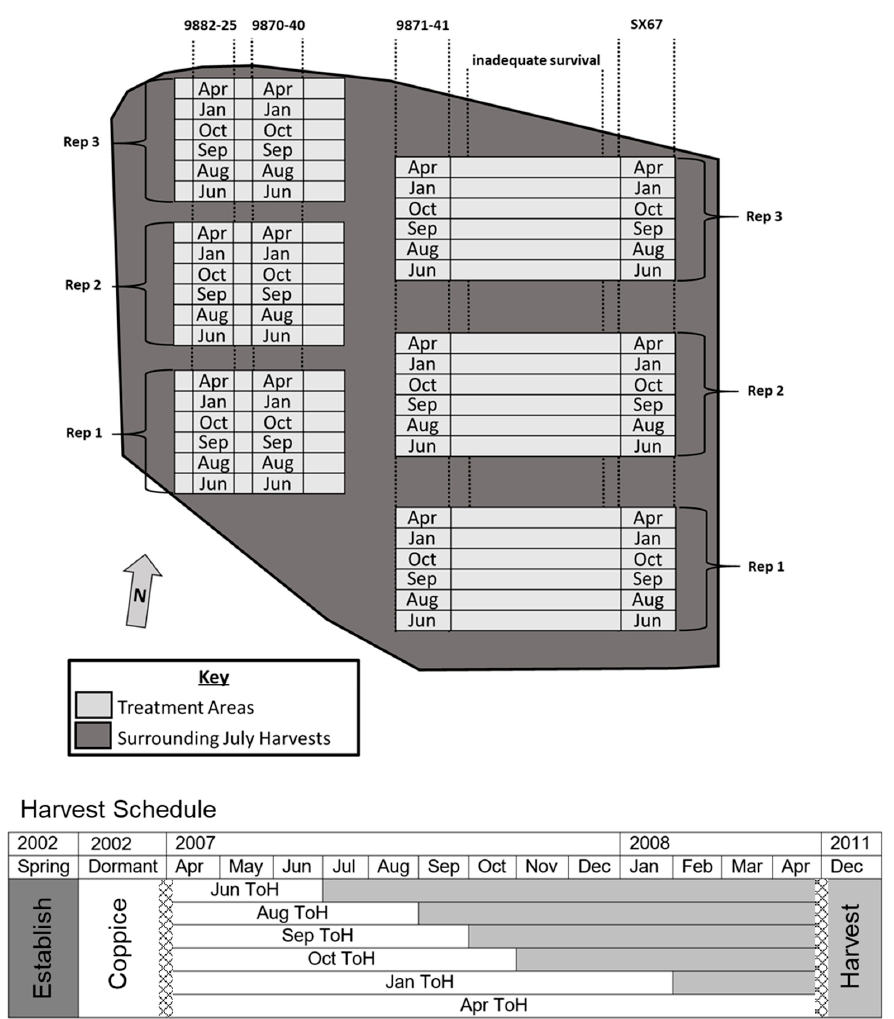
Figure 1. Schematic of the experiment with the four cultivars used in the study and layout of plots and replications. Dark grey area was harvested at the same time as the first harvest date (Jun). Grey areas indicate the time-of-harvest treatment (ToH) plots associated with the harvest dates, and areas that were treated but not included due to low survival. Table 2. Time of harvest, age of aboveground plant parts in months, growing degree days (GDD) for each harvest date, and stage of plant growth used to study the impacts of timing of harvest on nutrient removal and coppice regrowth of shrub willow crops.